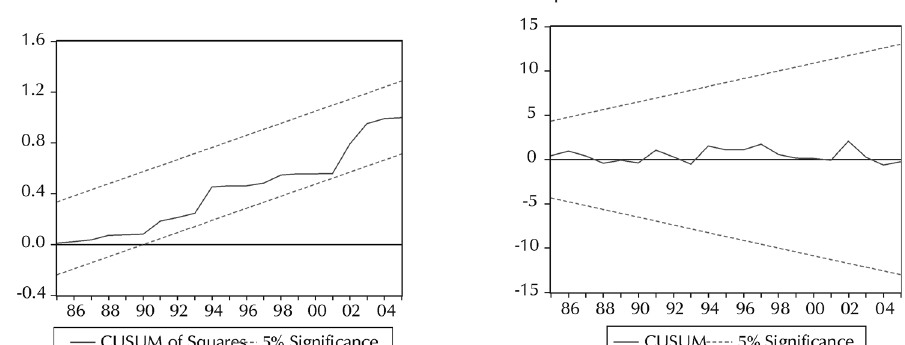
Plots of Cusum and Cusum of Squares for